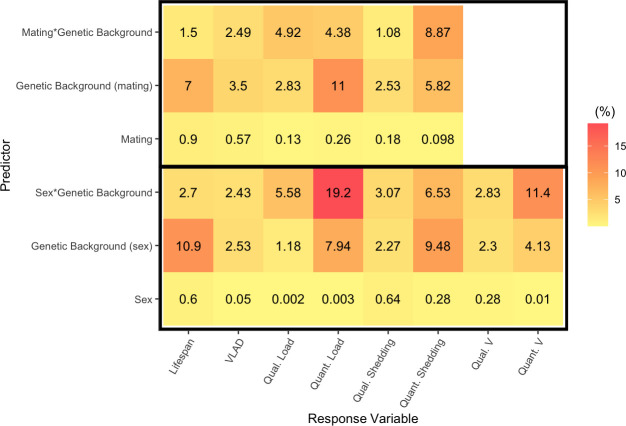
Summary of the percentage of variance or deviance explained by a subset of predictors in analyses of disease transmission potential and outcomes of infection.Separate analyses were used to test the effect of mating in females (top three rows) and sex (bottom three rows). We did not analyze the effect of mating on V, as this was not tested in the previously published social aggregation experiment [26]used to calculate V.